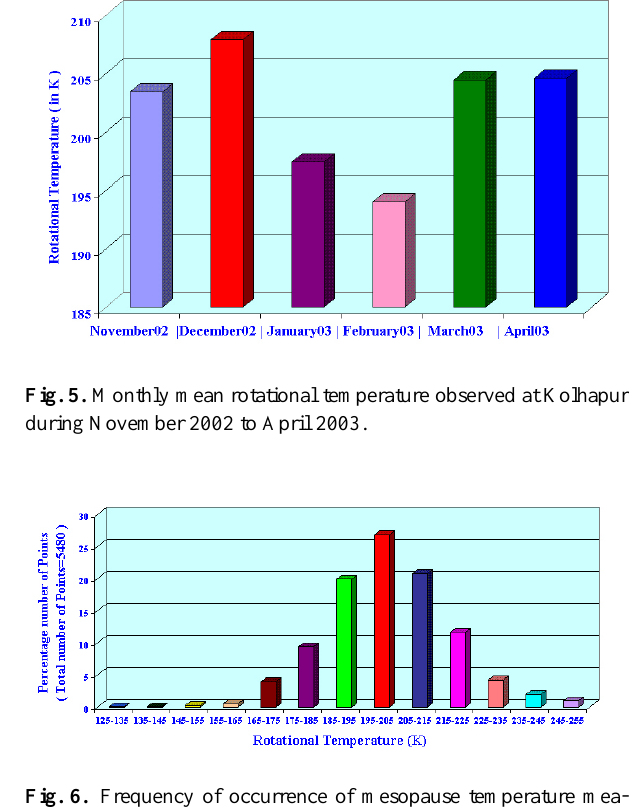
Fig. 6. Frequency of occurrence of mesopause temperature mea- surements at Kolhapur in 10K interval over the period 2 November 2002–29 April 2003.